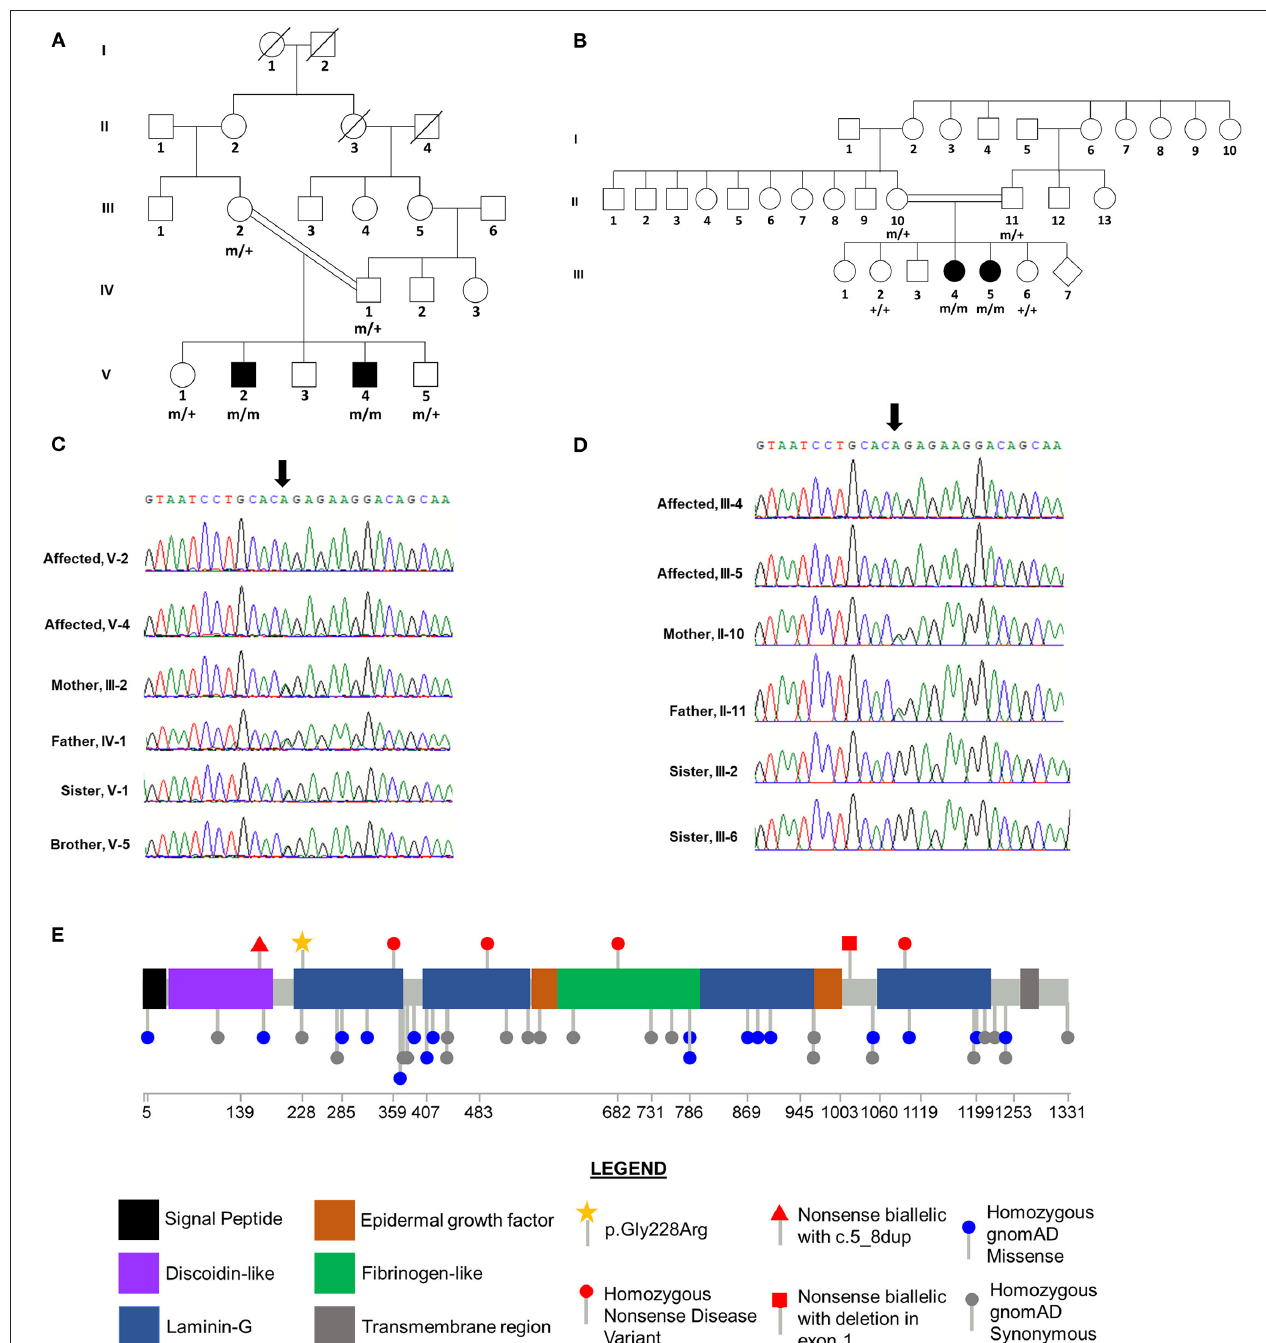
FIGURE 2 | CNTNAP2 p.Gly228Arg Variant Segregates with Disease in Consanguineous Families. Pedigrees for Family 1 (A) and Family 2 (B) with affected status (filled symbol) shown. Genotype for CNTNAP2 variant is shown under individuals who underwent Sanger sequencing. “ + ” wild-type allele, “m” mutant allele. Sequence traces from Sanger sequencing of CNTNAP2 in members of Family 1 (C) and Family 2 (D) . The position of the homozygous c.758G > A variant in the affected siblings is indicated by the arrow. Both parents in each family are heterozygous and unaffected siblings are either heterozygous or wild type for this nucleotide substitution. (E) Lollipop plot of previously reported homozygous or biallelic nonsense disease variants in the Human Genetic Mutation Database (HGMD; professional version 2021.3) and homozygous variants in gnomAD (v2.1.1). Star indicates novel homozygous p.Gly228Arg variant identified in this study. Domain and variant locations based on UniProt accession